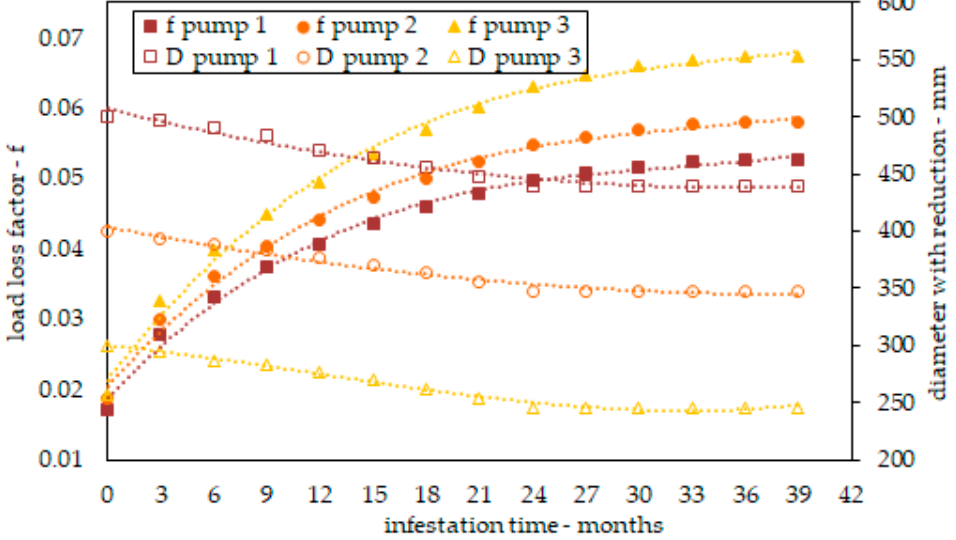
Figure 6. Temporal progression of the load loss factor (f) of the pumping system, calculated using Equation (8) and the reduction in the free flow diameter (D) due to biofouling, for the pumping systems coupled to pumps 1 (B1), 2 (B2) and 3 (B3). Data are presented in Table 1.